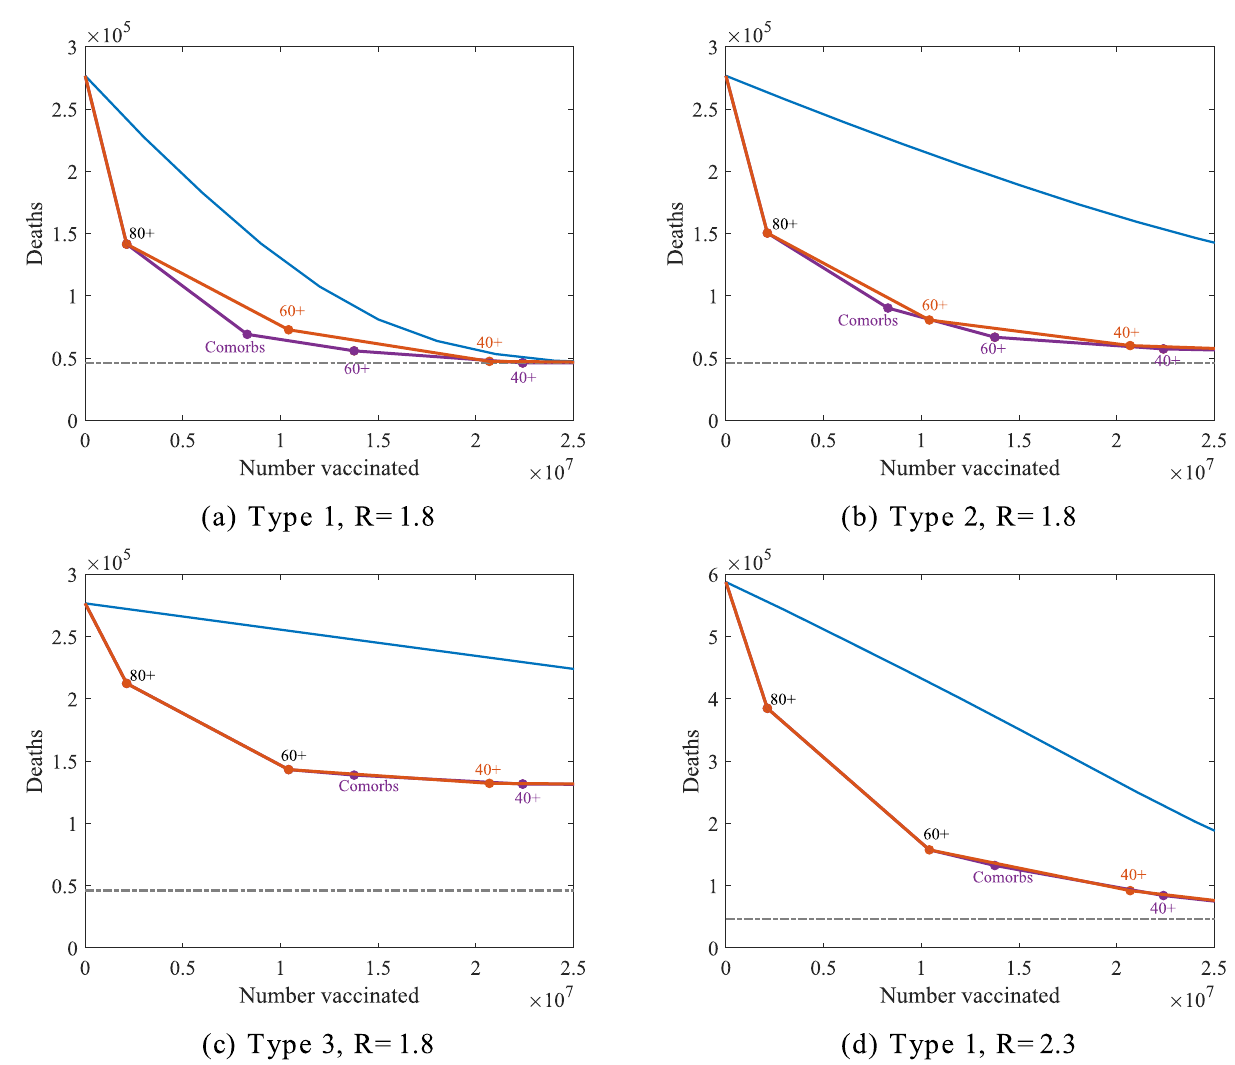
Fig 5. Comparison of vaccination ordering for four different vaccination scenarios. In each panel, the simulated points represent the number of subsequent deaths expected after vaccinating everyone up to a given group following an optimum strategy (identified by giving greatest reduction in deaths per vaccination in each instance) represented by the purple and orange connecting lines. Here the purple line shows the path of the optimum vaccination ordering of groups comprising of 20 year age bands together with comorbidities across all ages, and the orange line for age groupings only. The blue lines show an unbiased strategy with vaccinated numbers dispersed evenly across the population and the grey dotted line show the base level of morbidity from the first infection wave.